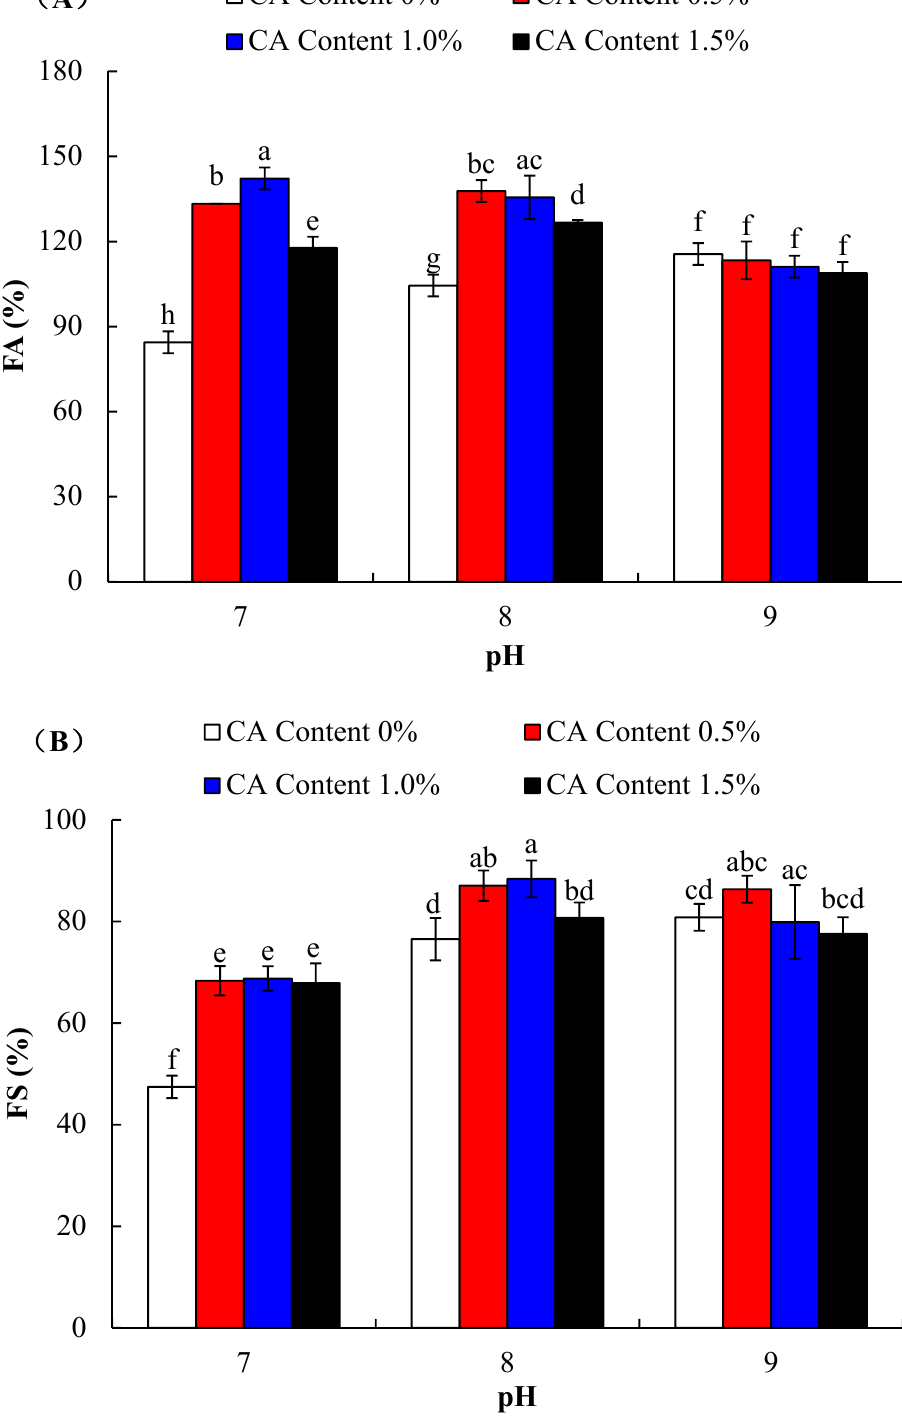
Figure 5. Foaming ability ( A ) and foam stability ( B ) of WPI incubated with CA (0%, 0.5%, 1.0% and 1.5%) at pH 7.0, pH 8.0, or pH 9.0, and at 50 °C for 6 h. Error bars represent the standard deviation of the mean of triplicate experiments. Values with different letters are significantly different ( p < 0.05).